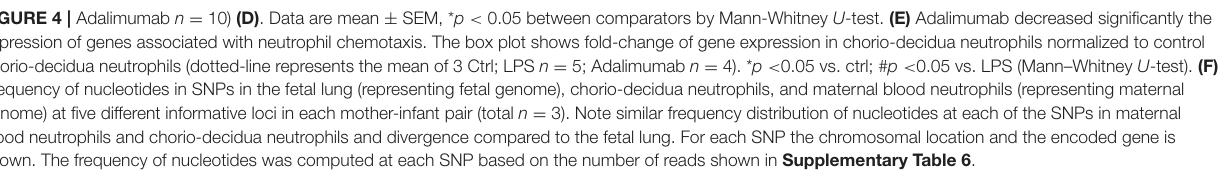
FIGURE 4 | Adalimumab n = 10) (D) . Data are mean ± SEM, * p < 0.05 between comparators by Mann-Whitney U -test. (E) Adalimumab decreased significantly the expression of genes associated with neutrophil chemotaxis. The box plot shows fold-change of gene expression in chorio-decidua neutrophils normalized to control chorio-decidua neutrophils (dotted-line represents the mean of 3 Ctrl; LPS n = 5; Adalimumab n = 4). * p < 0.05 vs. ctrl; # p < 0.05 vs. LPS (Mann–Whitney U -test). (F) Frequency of nucleotides in SNPs in the fetal lung (representing fetal genome), chorio-decidua neutrophils, and maternal blood neutrophils (representing maternal genome) at five different informative loci in each mother-infant pair (total n = 3). Note similar frequency distribution of nucleotides at each of the SNPs in maternal blood neutrophils and chorio-decidua neutrophils and divergence compared to the fetal lung. For each SNP the chromosomal location and the encoded gene is shown. The frequency of nucleotides was computed at each SNP based on the number of reads shown in Supplementary Table 6